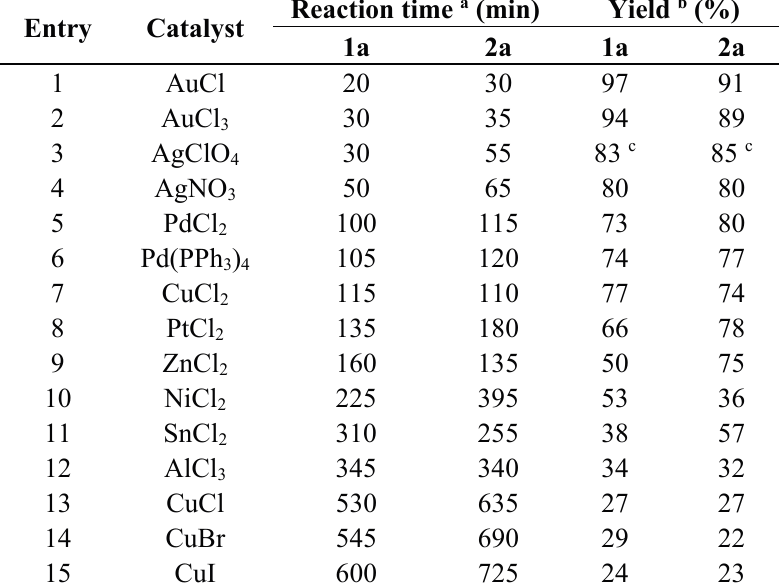
Table 2. Optimization of the coinage metal-catalyzed cycloisomerization of the model compound 1a and the model dien-1-ol 2a